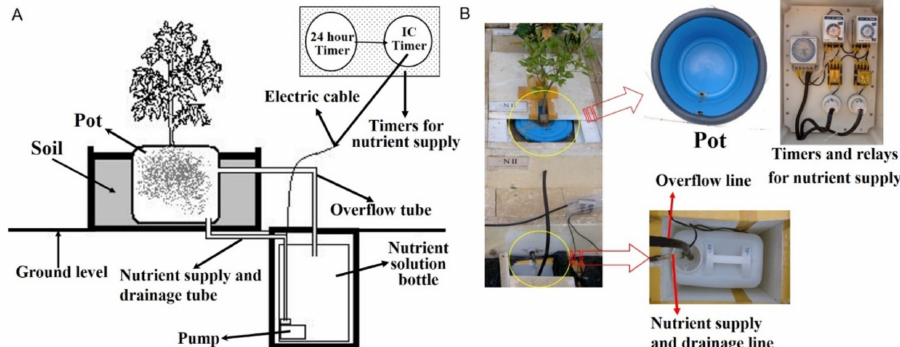
Figure 7. The hydroponics system used for culturing tangor cultivar ‘Shiranuhi’. ( A ) Schematic diagram of the hydroponics system. ( B ) Photos showing the actual set up of the pot, nutrient solution supply equipment, and nutrient solution supply